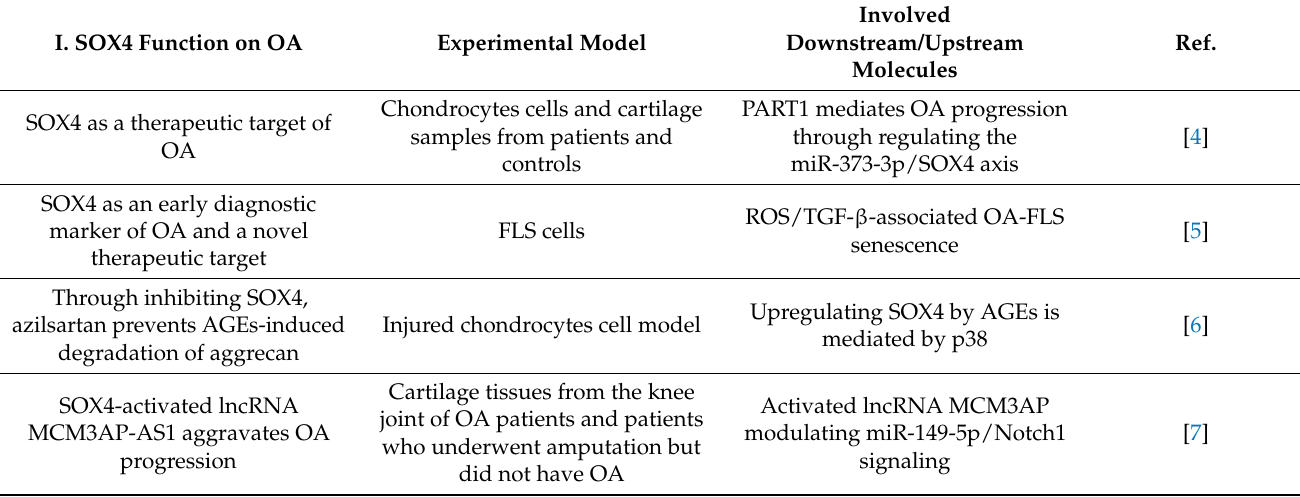
Table 1. SOX4 function during OA and